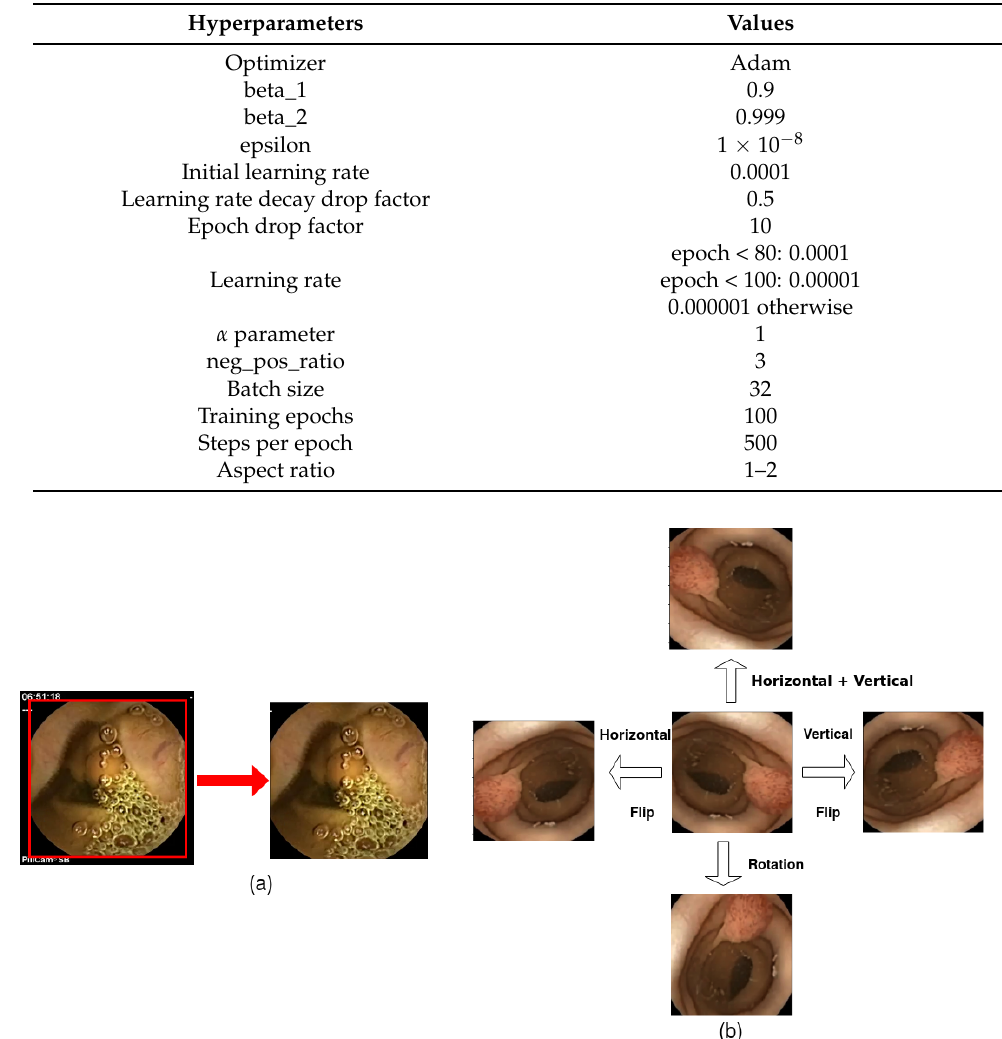
Table 2. Hyperparameter settings of the densely connected single-shot multibox detector (DC-SSDNet).